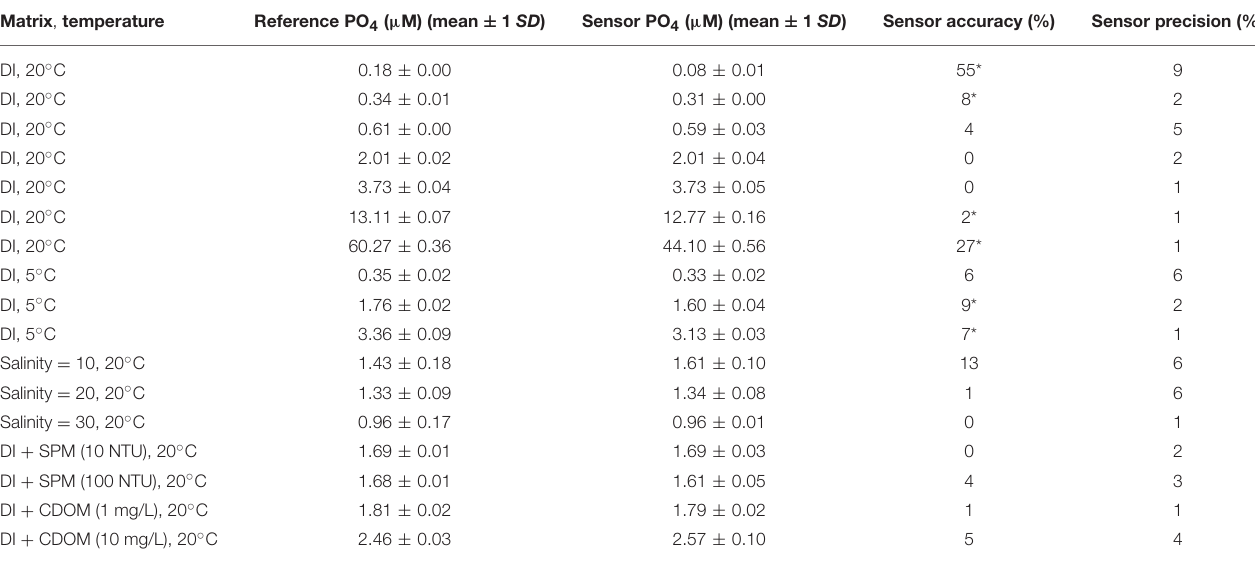
TABLE 2 | Analytical performance of Sensor 2 while immersed in a 250 L tank. Matrix ,